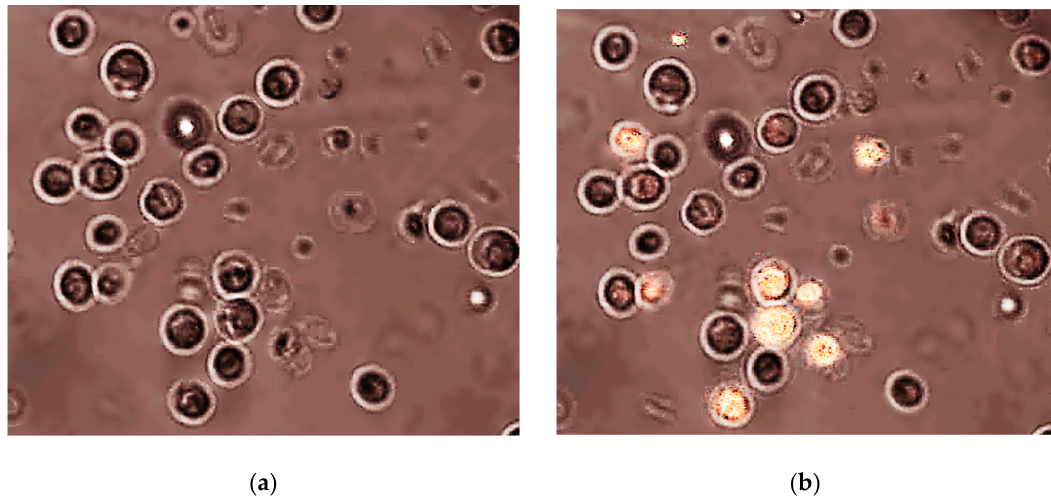
Figure 34. Confocal images of ( a ) untreated cell with intact membrane, preventing entry of PI (propidium iodide) dye, resulting in unstained cells and ( b ) cells treated with 300 mg / L ZnO NPs (zinc oxide nanoparticles) for 72 h showing PI stained cells due to compromised membrane integrity. (Modified after [163]).